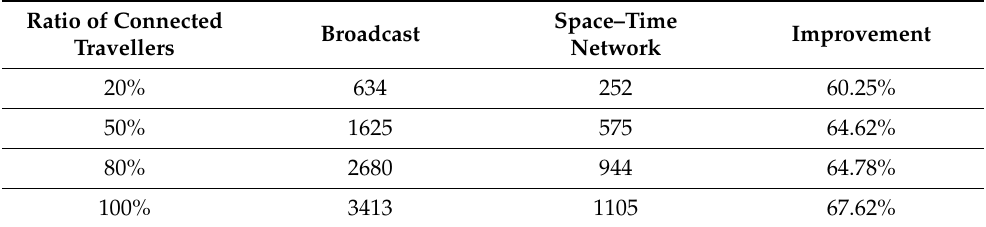
Table 1. Overall number of exchanged messages: broadcast versus space–time environment. Ratio of